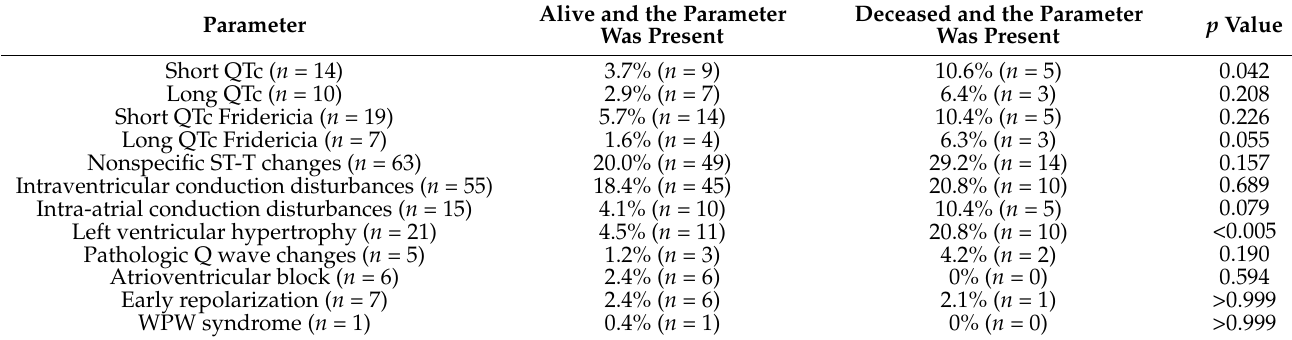
Alive and the Parameter Deceased and the Parameter p Value Was Present Was Present